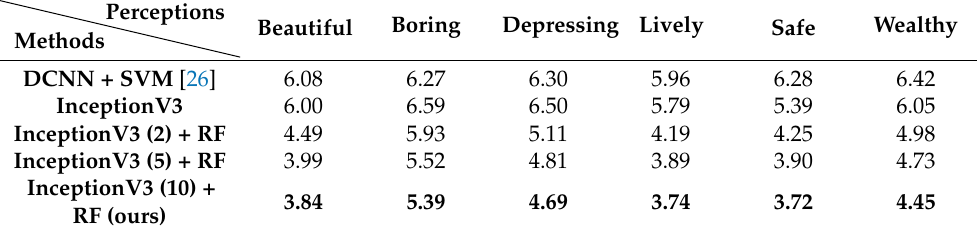
Table 6. Performance of the perception models (MSE).